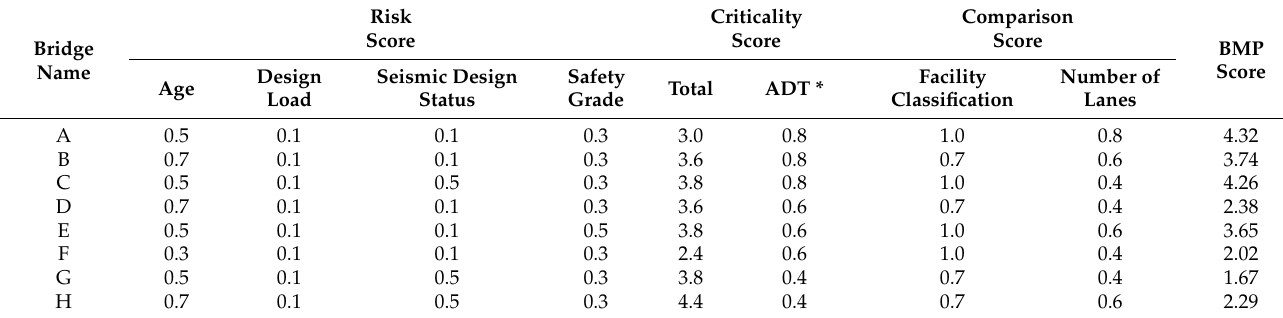
Figure 6. Results by maintenance priority.